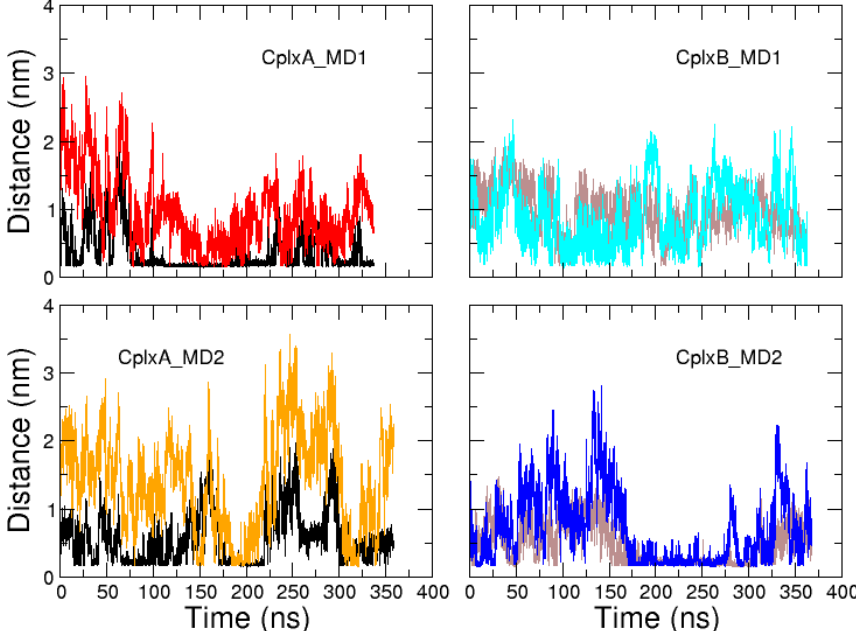
Figure 7. Time evolutions of minimal distances between actin and segment 28 NSRPVS 33 in simulations of CplxA (red and orange lines) and segment 56 GQESTP 61 in simulations of CplxB (cyan and blue lines). For comparison, time evolutions of minimal distances between actin and segments 22 LKKV 25 and 50 LKSV 53 are displayed with black and brown lines,